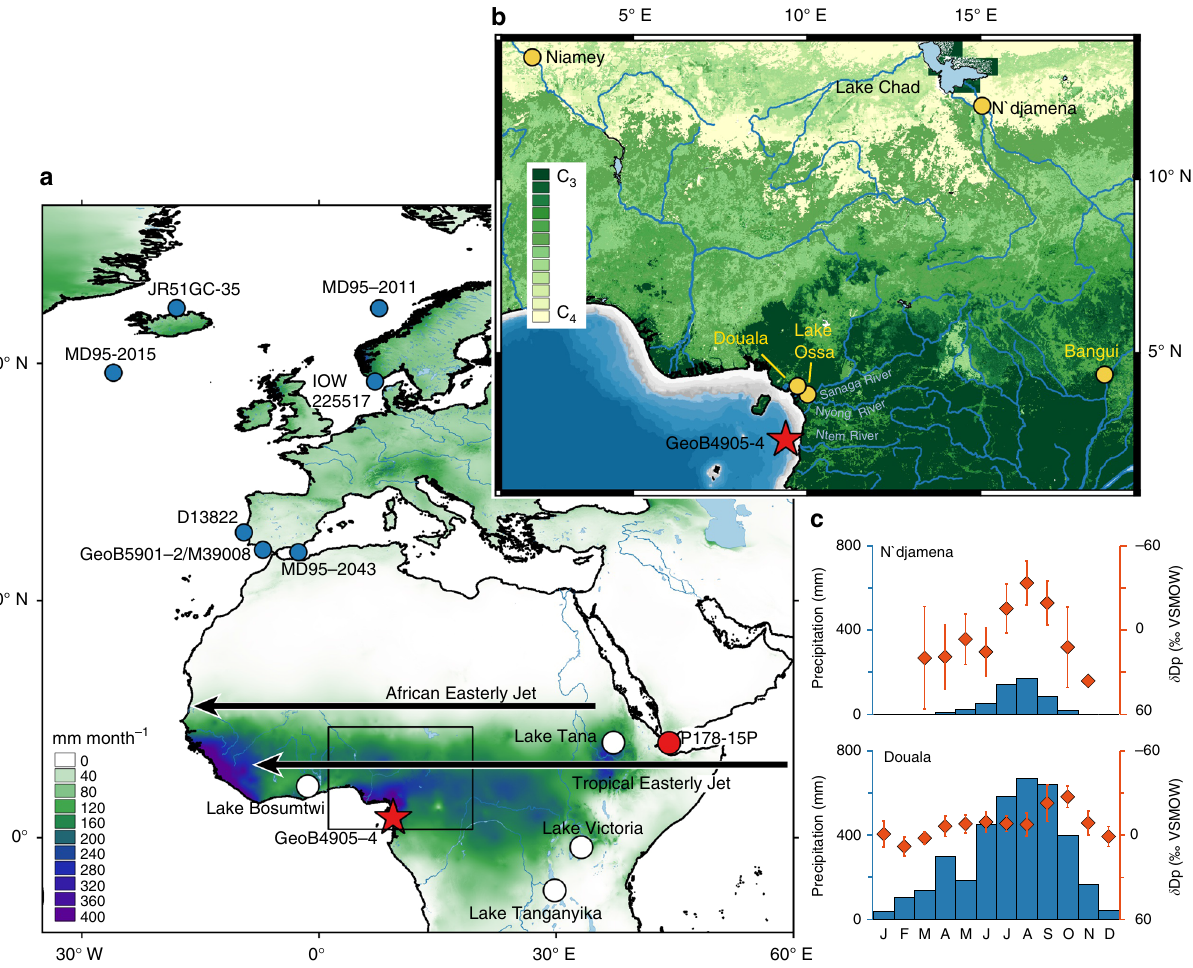
Fig. 1 Maps of the study area and climatology. a Colours represent mean monthly precipitation (mm) for the months Jun to Oct, the primary wet seasons for southern Cameroon and the Sahel. Red star marks the study site GeoB4905-4 (2°30.0 ´ N, 09°23.4 ´ E) in the Gulf of Guinea. Red dot marks the Gulf of Aden P178-15P core site 4 , white dots mark other sites discussed in the text and blue dots mark SST records from Supplementary Table 1. Black arrows mark position of TEJ and AEJ in summer 13 . Black box marks the inset. b Zoomed-in map of the study region showing C 3 – C 4 vegetation distribution, rivers and bathymetry. Yellow dots mark the Douala, N ’ djamena, Niamey and Bangui GNIP stations, and Lake Ossa. Bathymetry shallower than 120 m is coloured in grey. c Monthly precipitation amount and δ D p data for N ’ djamena, Chad and Doula, Cameroon 27 , highlighting the large seasonal δ D p changes in the Sahel compared to equatorial regions. Error bars represent standard deviation (1 σ ) of monthly